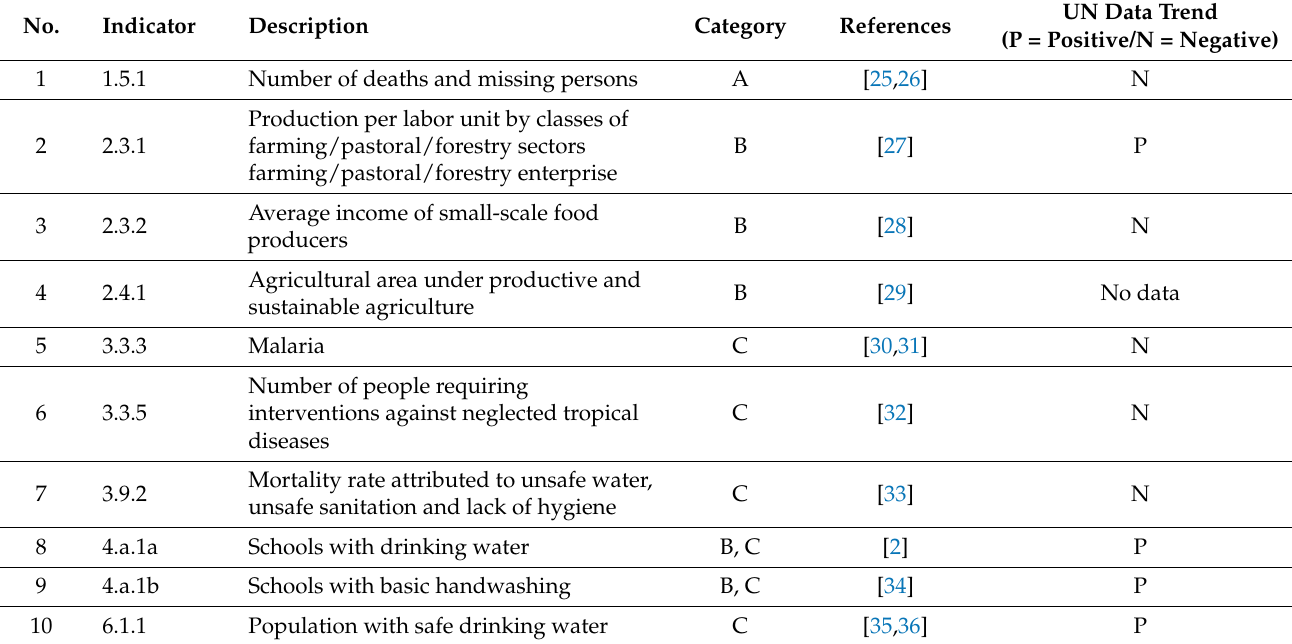
Table 1. List of the selected water-related